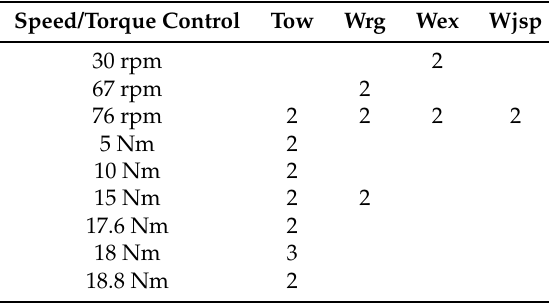
Table 3. Number of tests done for a specific